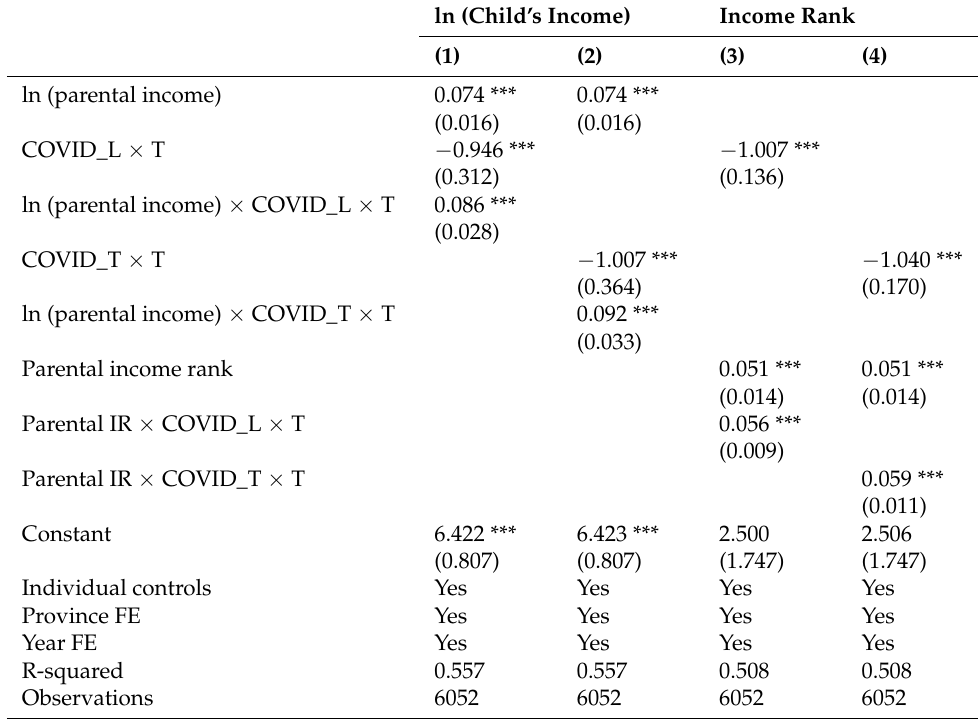
Table 2. The effects of COVID-19 shock on intergeneration income mobility. ln (Child’s